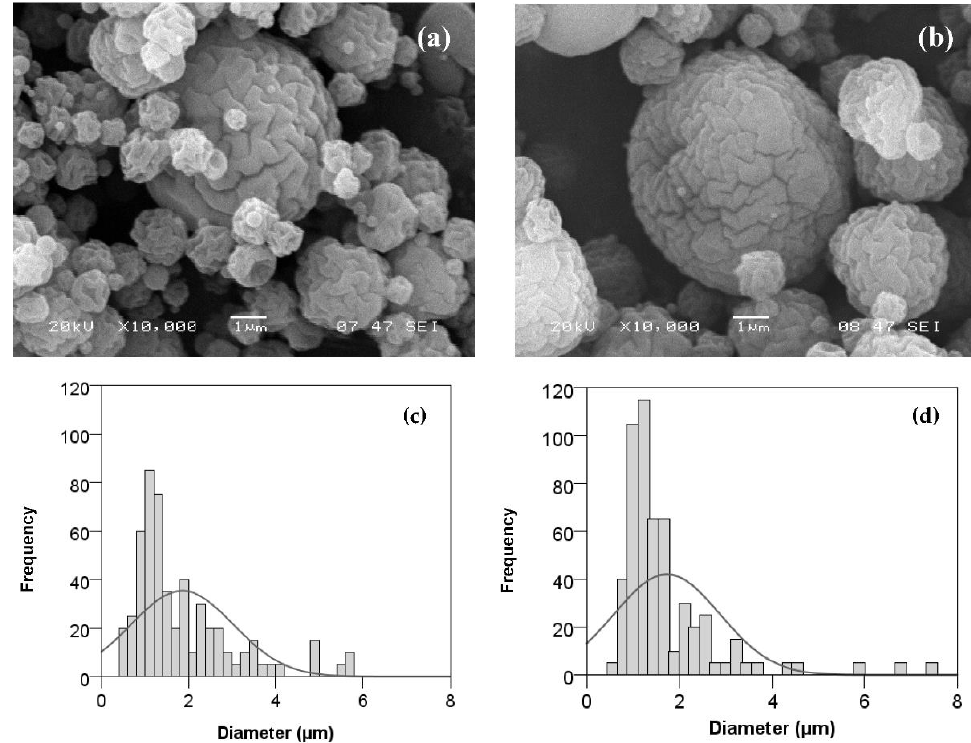
Figure 6. SEM images and size distribution (determined by ImageJ) of 0.10% ( v / v ) Flavourzyme ® loaded in chitosan − TPP microcapsules at 0.5% ( w / v ). Inlet temperature: 130 °C ( a , c ) and 160 °C ( b , d ).